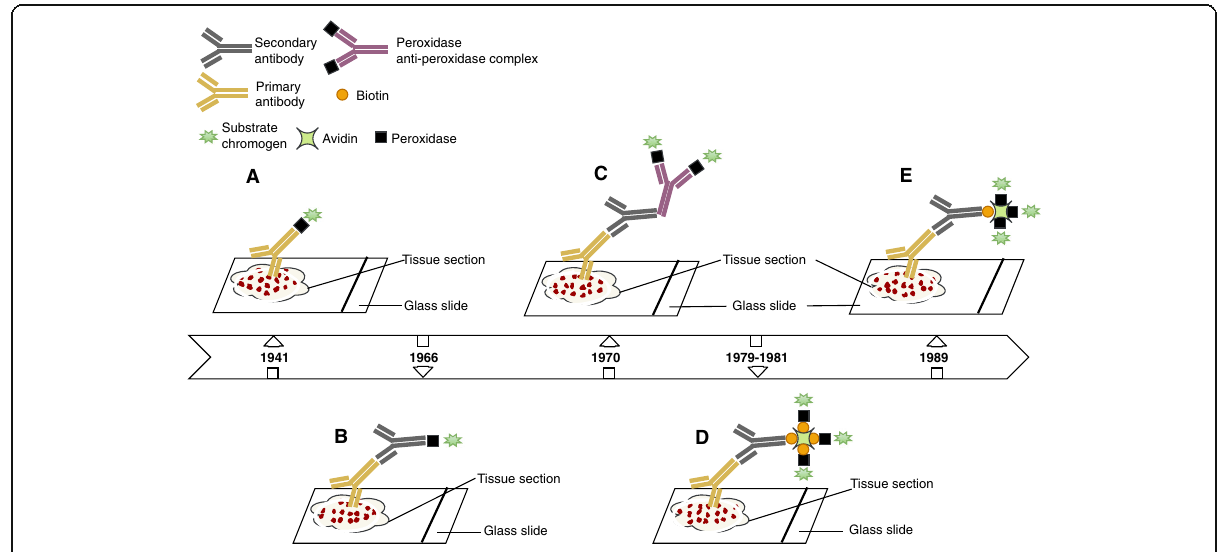
Fig. 2 Schematic representation of immunohistochemical methods. A : direct method, B : indirect method, C : PAP complex procedure, D : ABC procedure, E : LAB